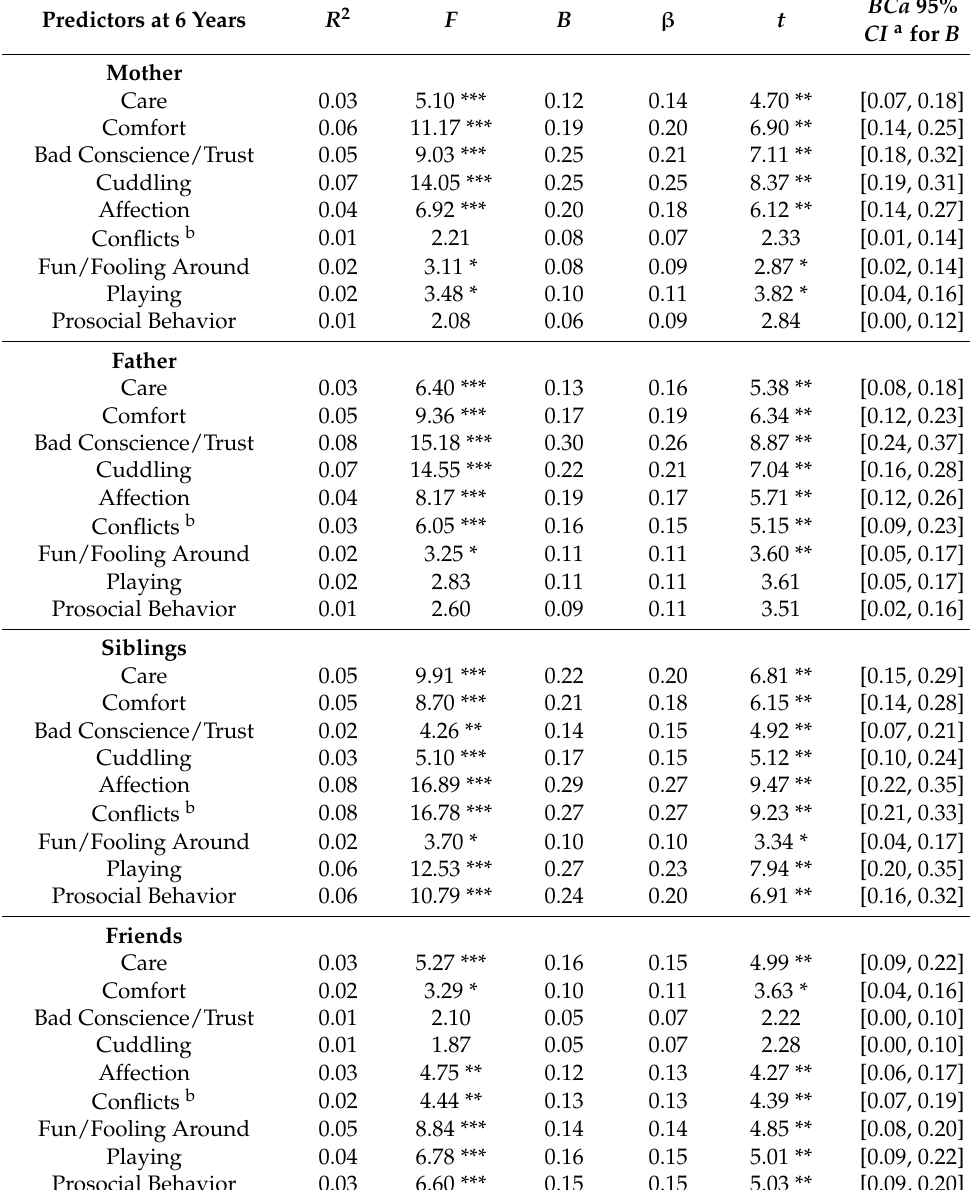
Table 3. Results of multiple linear regressions predicting valence scores at 8 years by valence scores at 6 years, separately for social relationship quality subscales and social relationship types ( N =